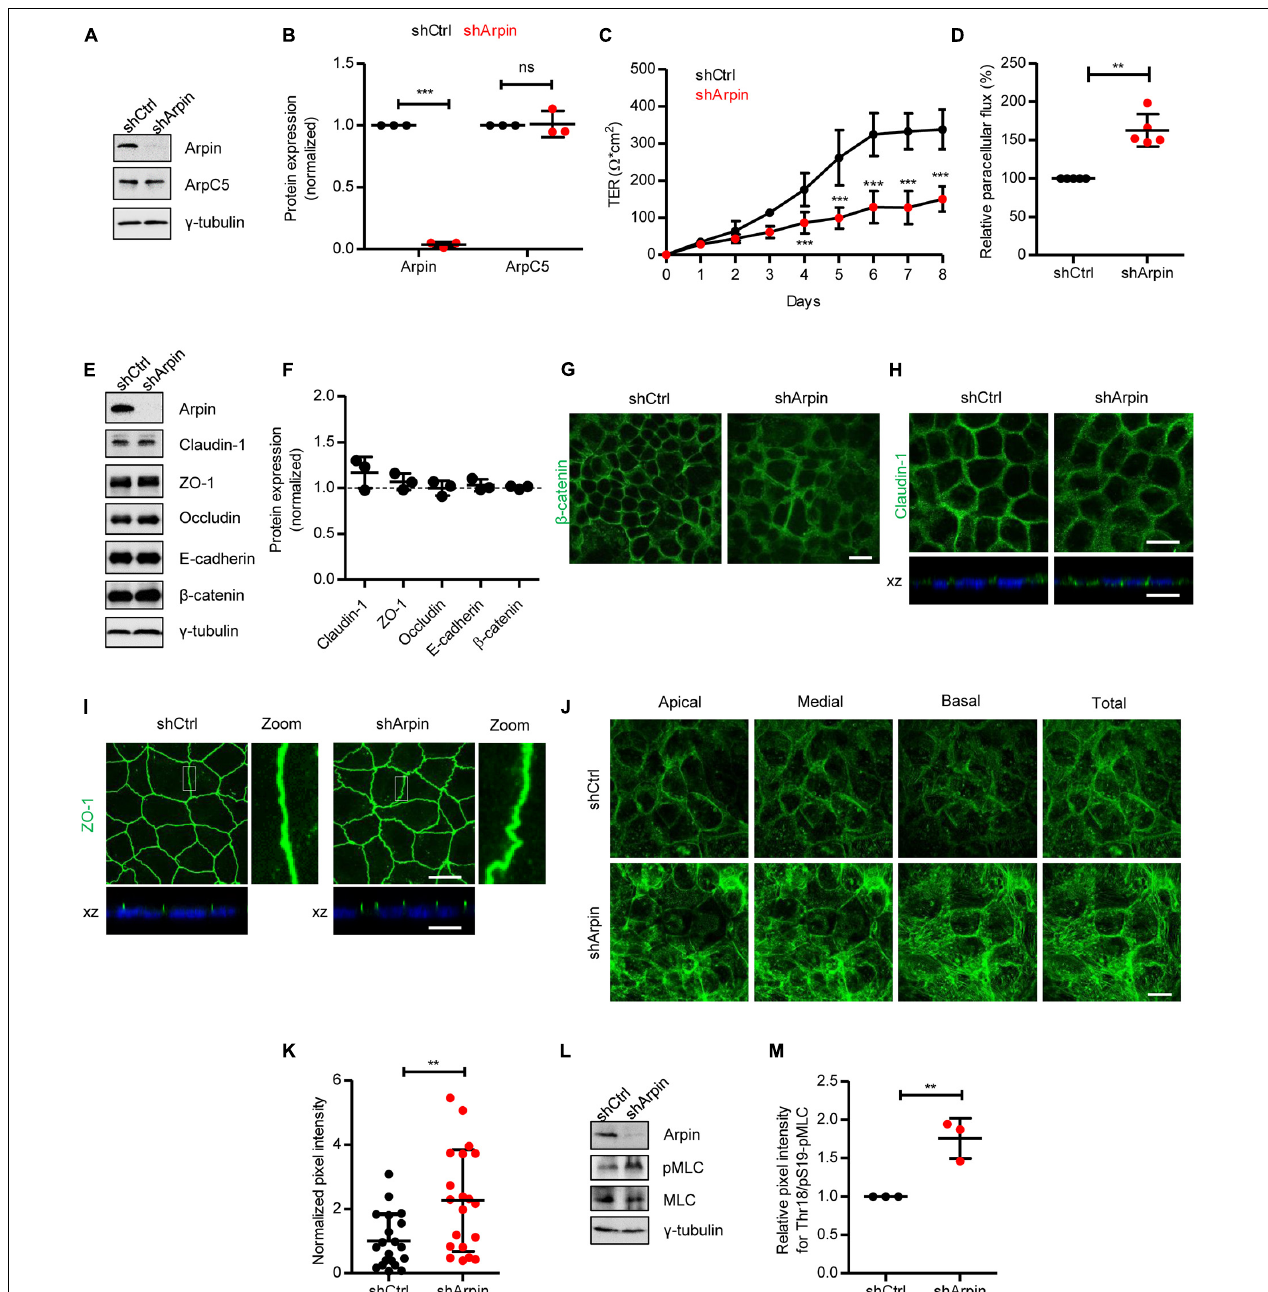
FIGURE 2 | Arpin depletion causes hyperpermeability and altered architecture of junctions and the actin cytoskeleton. (A) Western blot for arpin and ArpC5 of lysates from control (shCtrl) and arpin-depleted (shArpin) Caco-2 cells. (B) Densitometric analysis of panel (A) ( n = 3; two-tailed t -test). (C) Transepithelial electrical resistance (TER) development in control and arpin-depleted Caco-2 monolayers ( n = 6; two-way ANOVA with Bonferroni‘s correction). (D) Paracellular flux using confluent control and arpin-depleted Caco-2 monolayers ( n = 3; two-tailed t -test). (E) Western blot for claudin-1, zonula occludens 1 (ZO-1), occludin, E-cadherin, and β -catenin in control and arpin-depleted cells. (F) Densitometric analysis of panel E ( n = 3; two-tailed t -test). (G) Immunostaining for β -catenin (green) in control and arpin-depleted Caco-2 monolayers ( n = 3). Bar = 20 µ m. (H) Immunostaining for claudin-1 in control and arpin-depleted Caco-2 monolayers. xz-planes are shown below for claudin-1 (green) and the nuclei as reference (blue). Images are representative of n = 3. Bar = 20 µ m. (I) Immunostaining for ZO-1 (green) in control and arpin-depleted Caco-2 monolayers. xz-planes are shown below with nuclei as reference (blue); n = 3. 3 × digital zoom of junctions is shown on the right. Bar = 20 µ m. (J) Location of apical, medial, and basal actin filaments in control and arpin-depleted Caco-2 cells stained with phalloidin; n = 4. Bar = 20 µ m. (K) Actin density quantification normalized to the average of shCtrl cells ( n = 20 cells per condition randomly selected from four independent experiments, two-tailed t -test). (L) Western blot for myosin-II light chain (MLC) and pMLC in control and arpin-depleted cells. (M) Densitometric analysis of panel (L) ( n = 3; two-tailed t -test). ** p < 0.01; *** p < 0.01. ns = not significant.